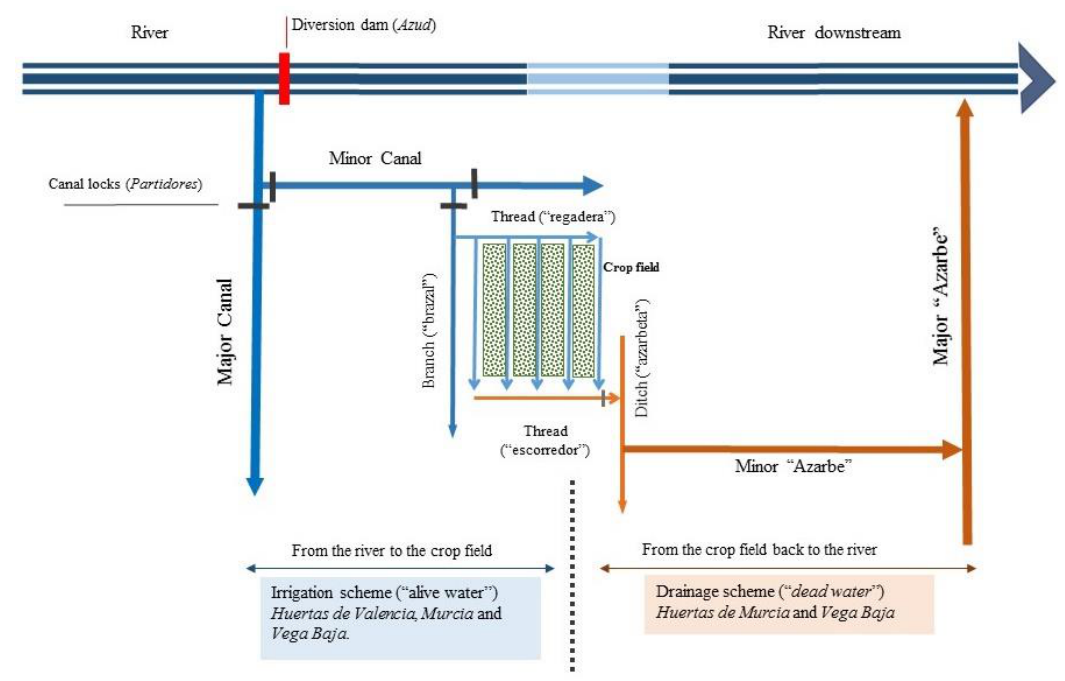
Figure 5. Water distribution circuitry scheme. Left (blue) irrigation canals, water diverted from the river to the fields. Right (orange) drainage canals, exceeding irrigation water redirected towards the river. Source: Authors. Diagram based on water regulation documents. Not to scale.